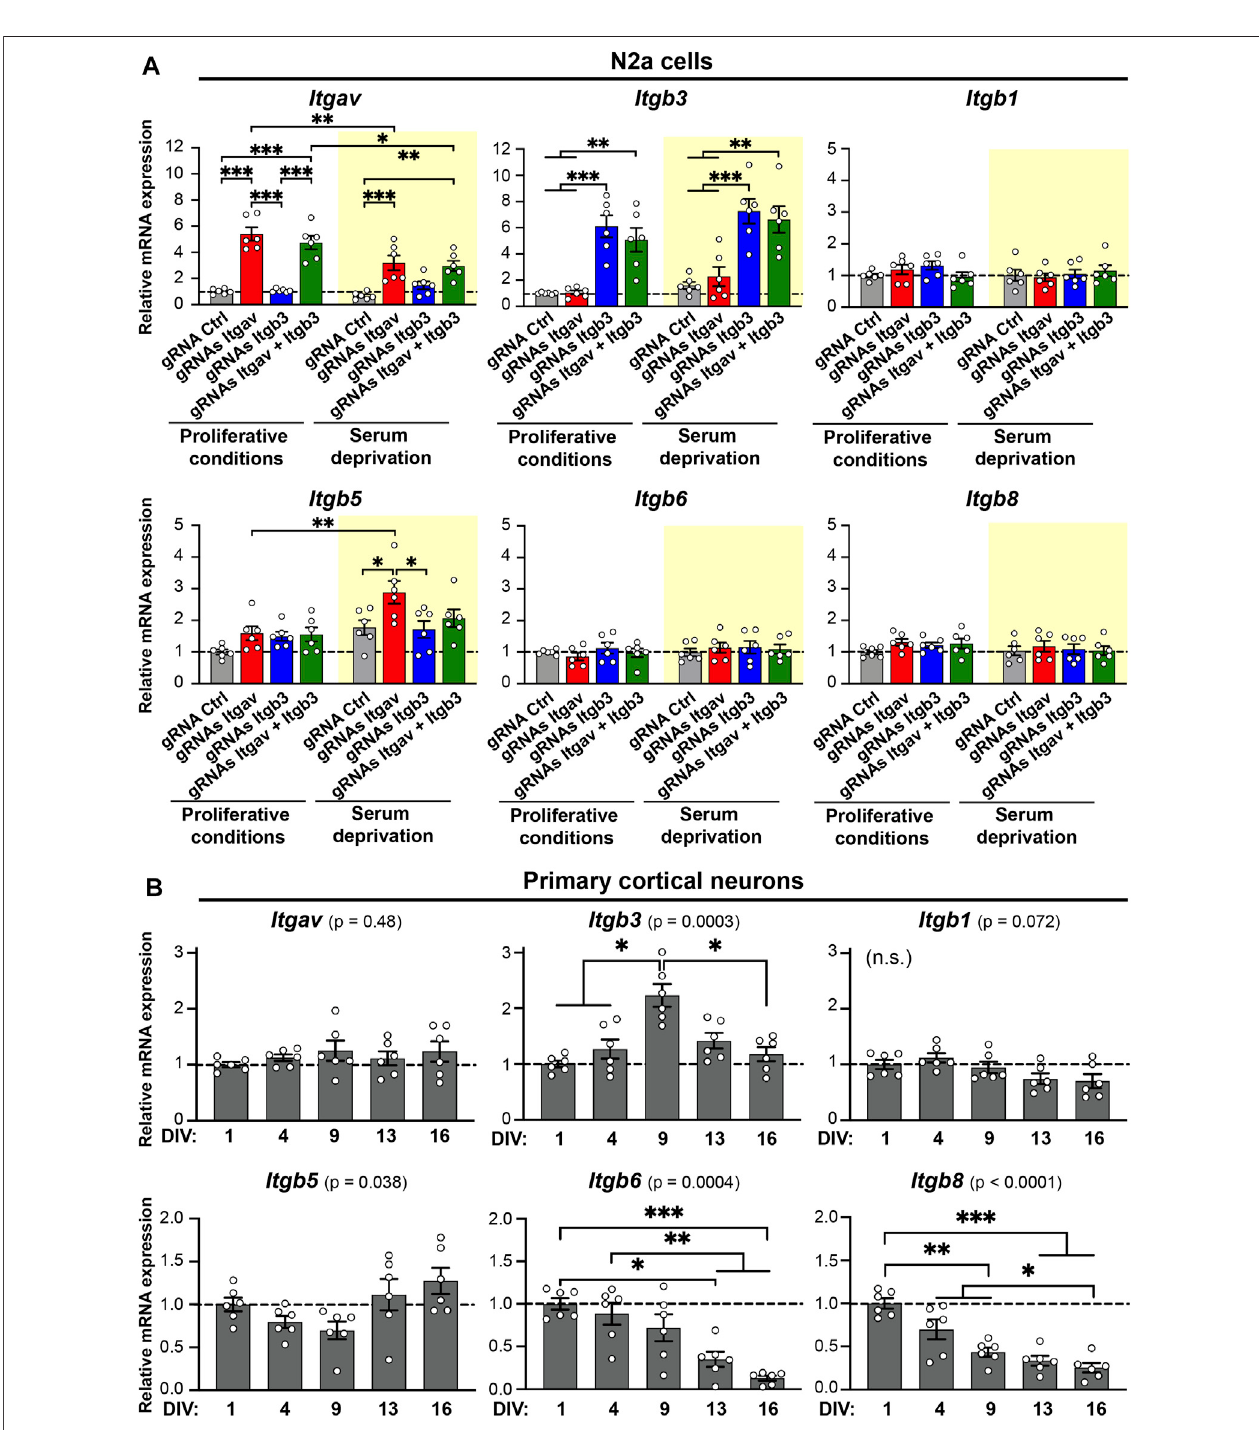
FIGURE 4 | Expression levels of Itgav , Itgb3 , Itgb1 , Itgb5 , Itgb6 , and Itgb8 in N2a cells and primary cortical neurons. (A) Quanti fi cation of Itgav , Itgb3 , Itgb1 , Itgb5 , Itgb6 ,and Itgb8 mRNAlevelsinresponsetoCRISPRafor Itgav and/or Itgb3 inN2acellsunderproliferativeconditions(whitebackground)orfollowingserumdeprivation (yellow background). mRNA expression was normalized to the values of samples expressing gRNA Ctrl under proliferative conditions within the same RT-qPCR plate. * p < 0.05, ** p < 0.01, *** p < 0.001, two-way ANOVA followed by Tukey ’ s post-test ( n = 6 from 3 independent cultures). CRISPRa for Itgav is accompanied by an increase in Itgb5 expression levels in differentiating N2a cells. F ratio and p values for two-way ANOVA statistics are as follows, Itgav: gRNA effect: F (3, 40) = 44.71, p < 0.001(***);serumstarvationeffect:F (1,40) =13.69, p < 0.001(***);Serumstarvation×gRNAinteraction:F (3,40) =5.351, p =0.003(**). Itgb3: gRNAeffect:F (3,40) =30.94, p < 0.001(***); serum starvation effect: F (1,40) = 5.075, p =0.03 (*); serum starvation ×gRNA interaction: F (3, 40) =0.1581, p = 0.92. Itgb1: gRNA effect:F (3,40) =0.5449, p =0,65;serumstarvationeffect:F (1,40) =0.6286, p =0.43;serumstarvation×gRNAinteraction:F (3,40) =1.189, p =0.33. Itgb5: gRNAeffect:F (3,40) =4.606, p =0.007